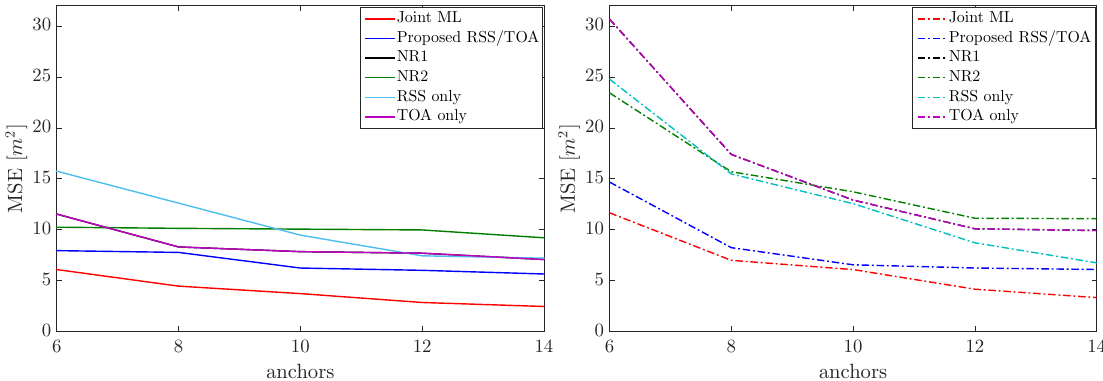
Figure 7. MSEs of the considered algorithms as function of the number of anchors N for α = 4 and σ = 4. ( left ) Ideal TOA/RSS parameters and ( right ) estimated TOA/RSS parameters.